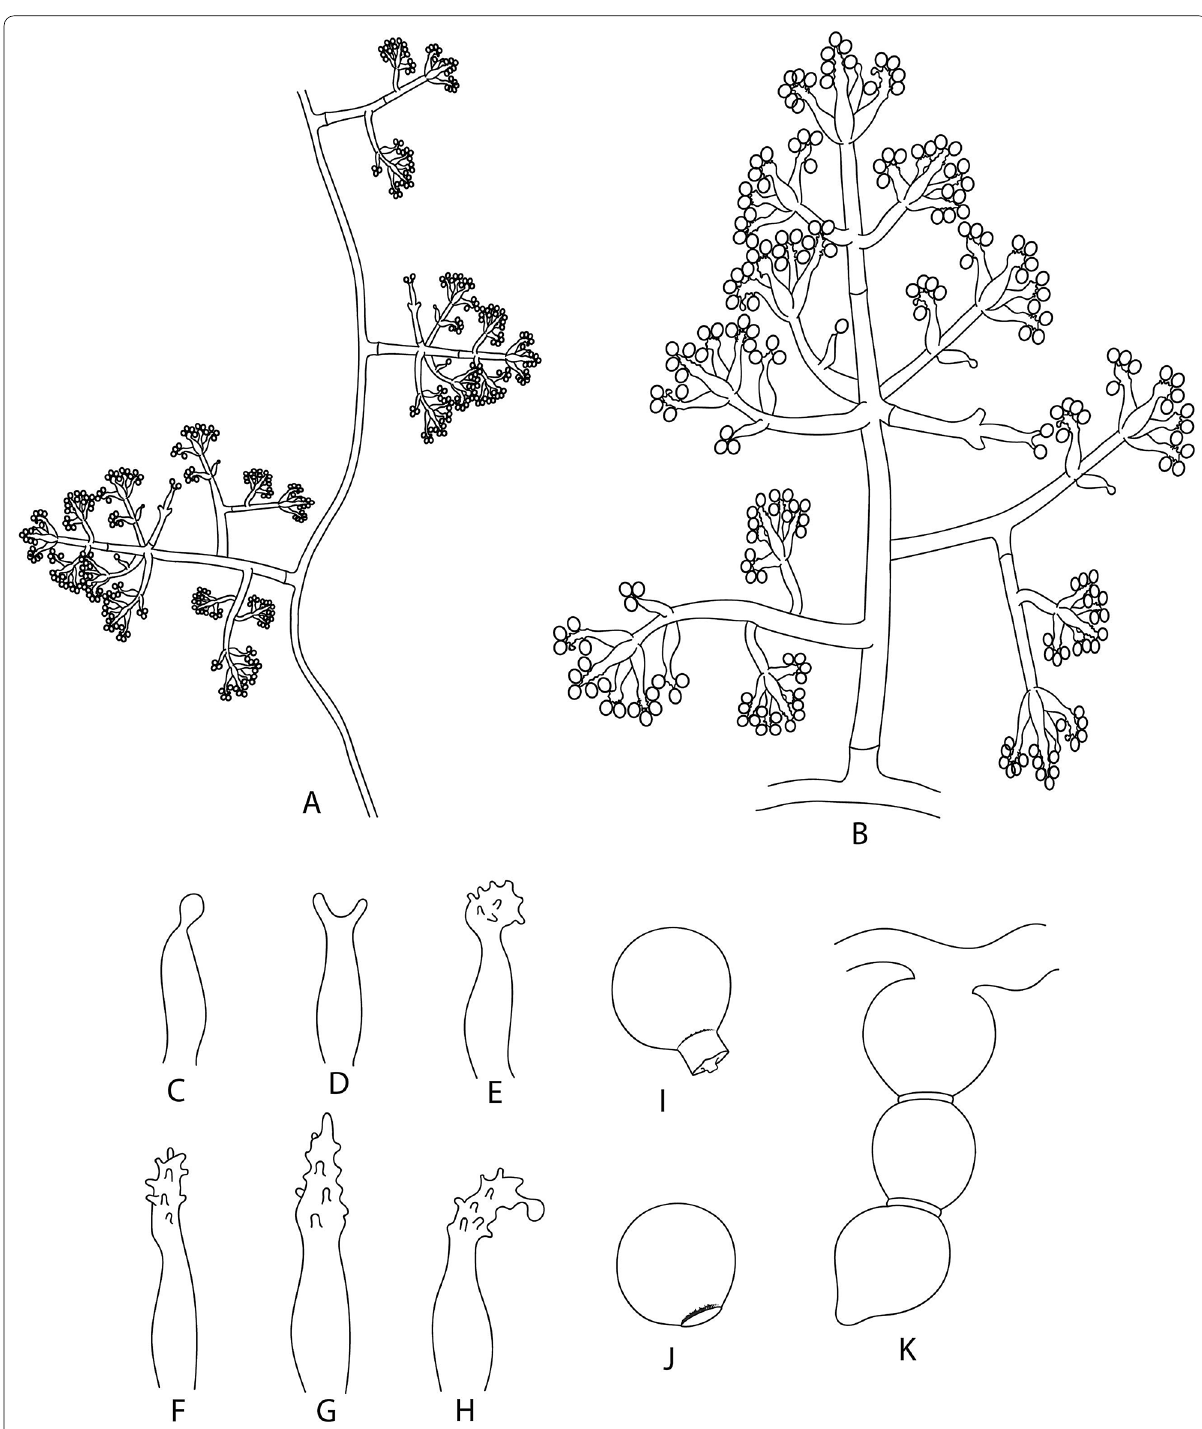
Fig. 6 Illustration of the microscopic structures of Sympodiorosea kreiselii (syn . Escovopsis kreiselii ). A Pattern of disposition of conidiophores on aerial mycelium. B A conidiophore. C – H Shapes of the sympodial conidiogenous cells. I Conidia with denticle (detached from the conidiogenous cell), J Conidia with a hole (when the denticle remains on the conidiogenous cell). K Chlamydospores in